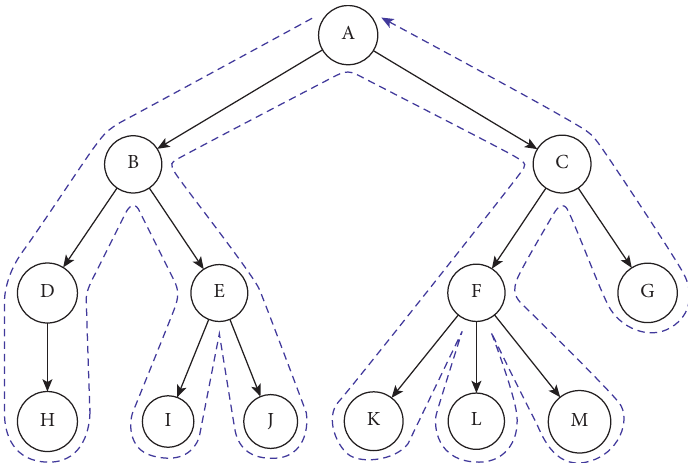
Figure 3: Depth-first traversal of a tree